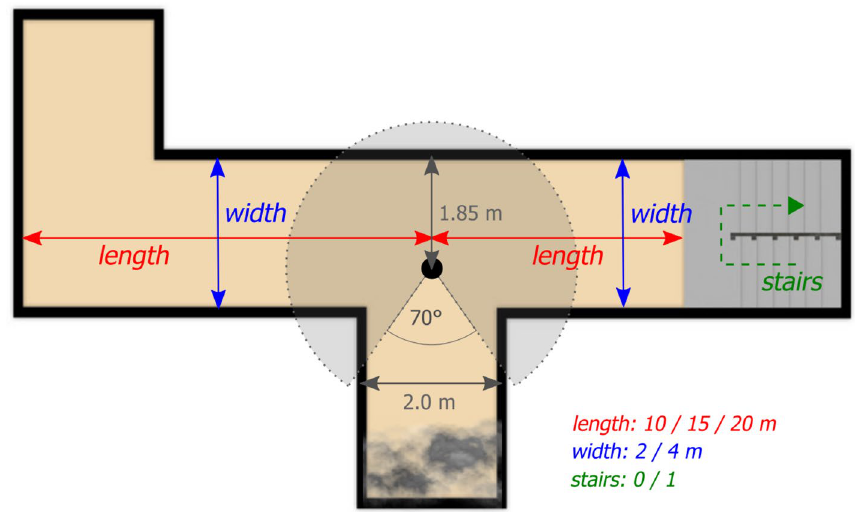
Figure 3. A sample decision point layout with an explanation of changing experimental